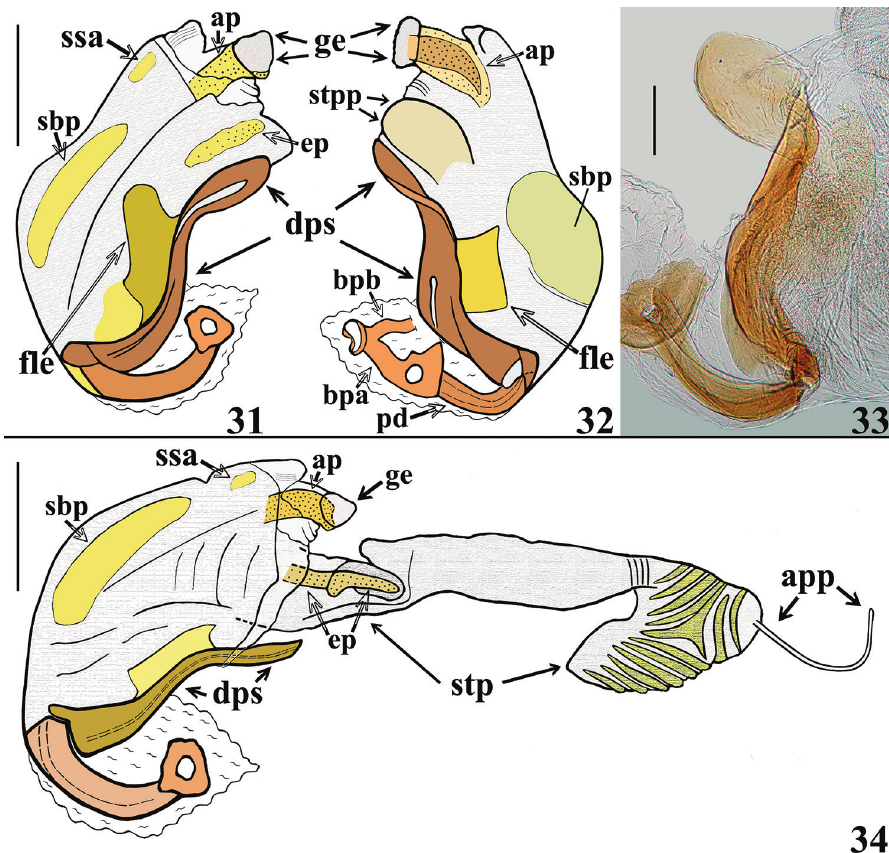
Figures 31–34. Zeraikia zeraikae sp. n., male genitalia, lateral views. 31–32 phallus not inflated 33 pedi- cel and dorsal phallotecal sclerite 34 phallus with endosoma inflated. ( ap apical process of endosoma; app appendix; bpa basal plate arm; bpb basal plate bridge; dps dorsal phallothecal sclerite; ep elongated process inside basal portion of subapical projection of endosoma wall; fle flat lateral expansion; ge globose expansion of endosoma; pd pedicel; sbp subbasal process of endosoma; ssa small subapical process of endosoma; stp subapical tubular projection of endosoma wall; stpp visible portion of subapical tubular projection not extended). Scale bars: 0.5 mm ( 31–32, 34 ); 0.2 mm ( 33